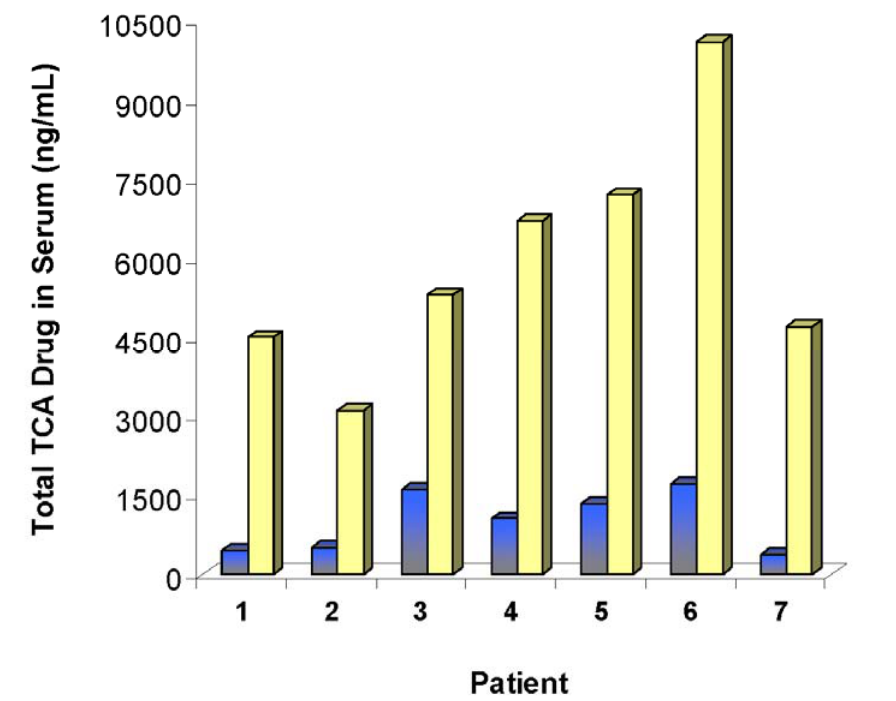
Figure 10. Total serum levels of various tricyclic antidepressant drugs in human patients experiencing drug overdose before treatment ( ) and after a third dose of drug specific antibody fragments ( )